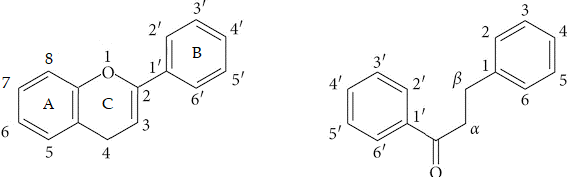
Figure 2. Atom numbering used in flavonoids with a C6-C3-C6 structure, shown in a flavonoid with a pyran ring ( left ) or an open chain form ( right ).